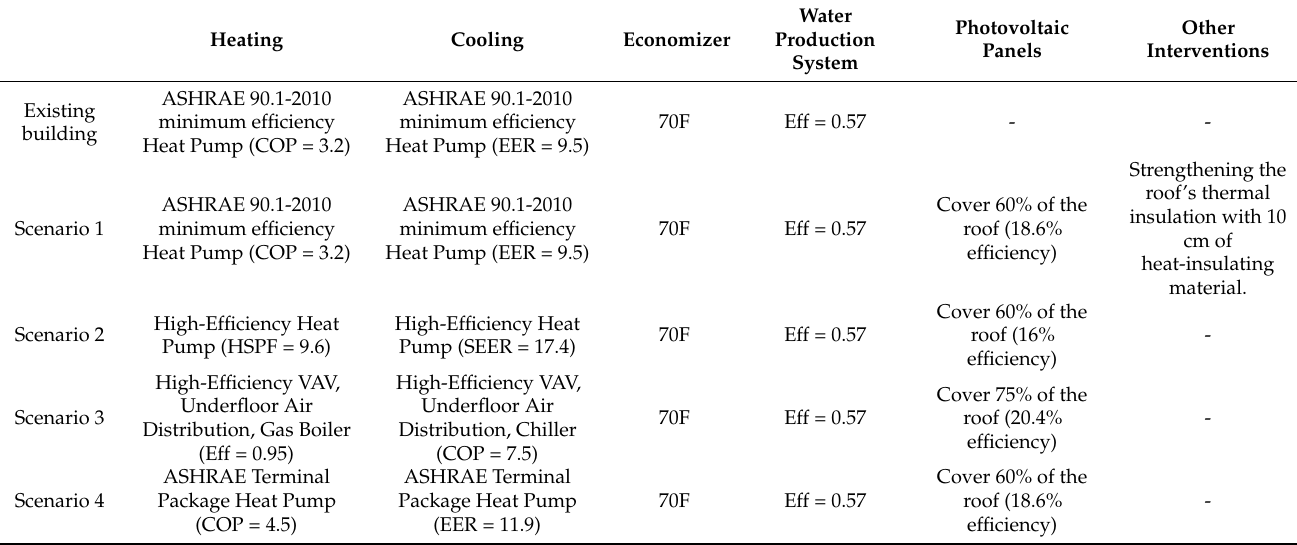
Table 8. Scenarios examined in Autodesk Revit software.